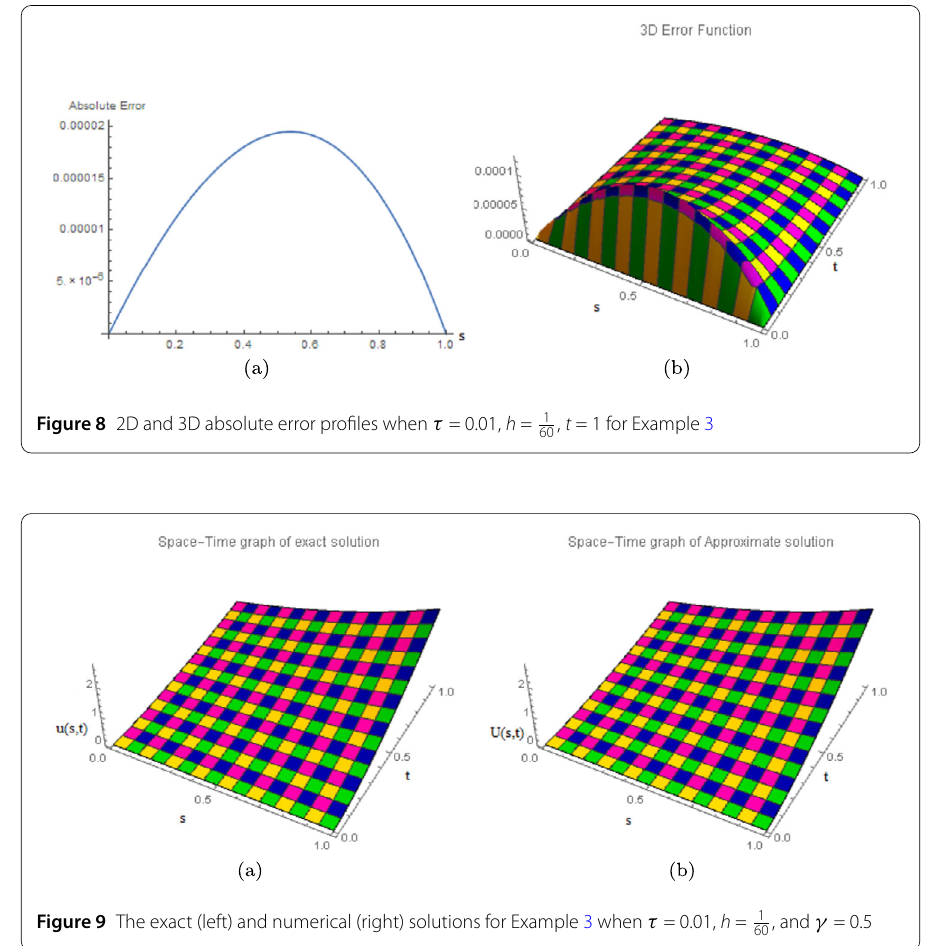
Table 5 The maximum errors when τ = 1 γ